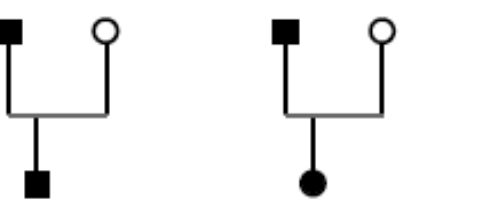
Figura 1 . Padrão de repetição de VAA em linha direta de parentesco: comportamento apresentado por um dos pais e repetido por um dos(as) fi lhos(as) ( N =34). Nota . Quadrados representam homens; círculos, mulheres; os símbolos preenchidos são indivíduos que apresentam associação álcool-violência.